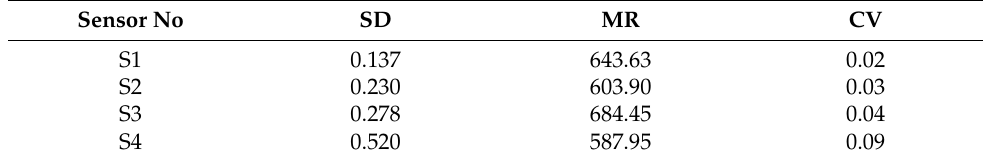
Table 5. Coefficient of variation (CV), standard deviation (SD) and mean response (MR) of the designed soil moisture sensors response measurements at 30% moisture